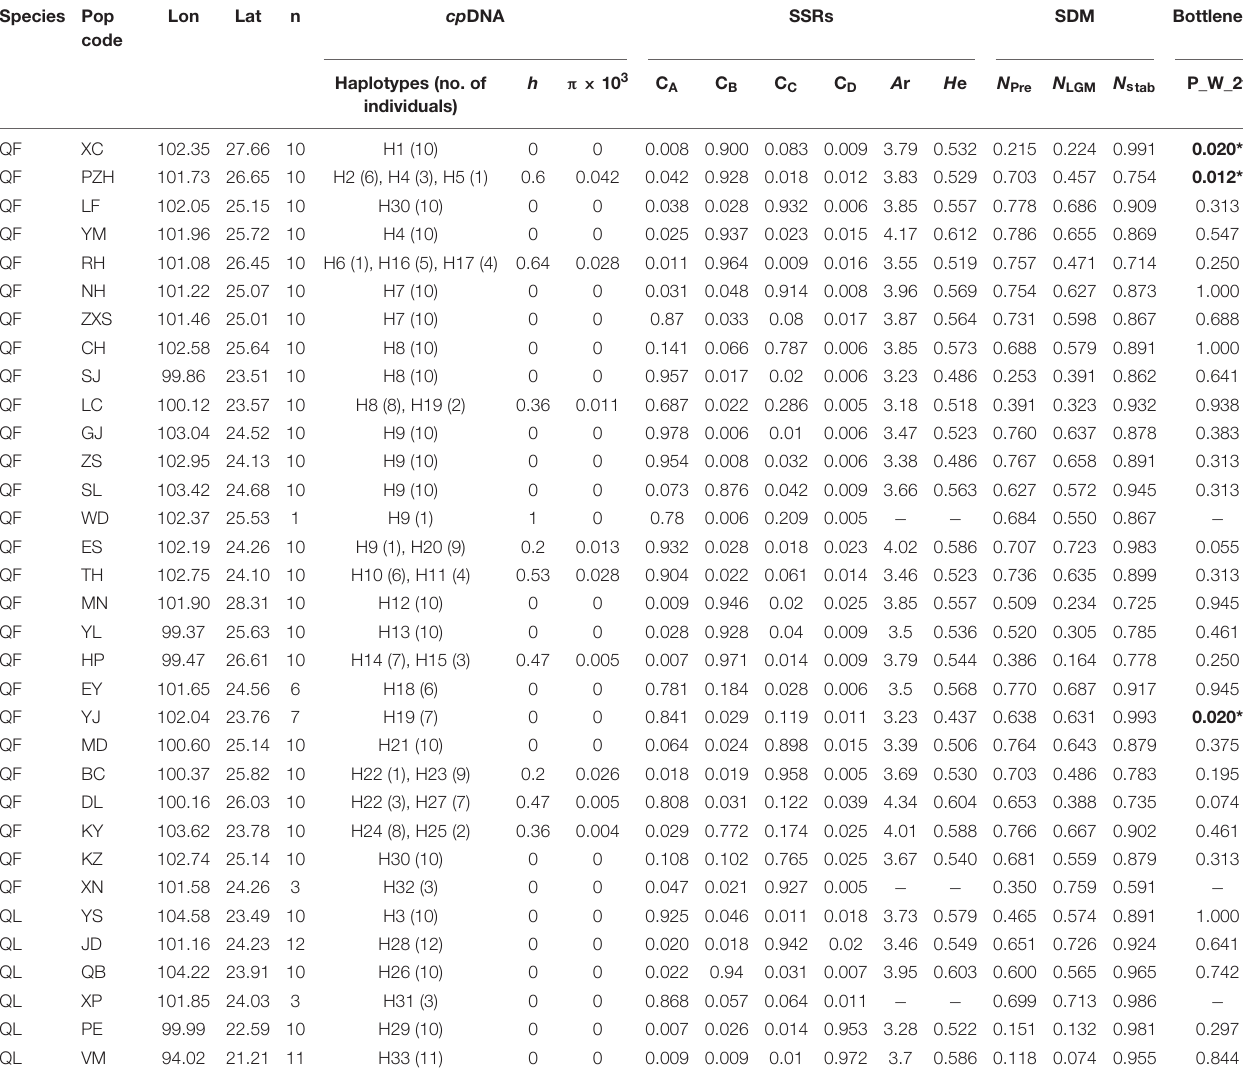
TABLE 1 | Sampling information, nSSR and cp DNA genetic diversity, probabilities of populations belonging to each genetic cluster ( C A , C B , C C , C D ) inferred by InStruct analyses, locality habitat suitability, stability obtained from SDMs, and bottleneck effect test for the Quercus franchetii complex. Species Pop